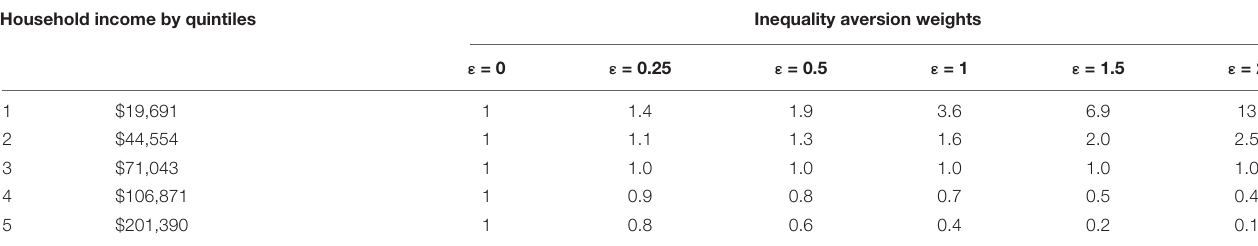
TABLE 3 | Household Income quintiles a (in $ CAD) (2016) (Lapointe, 2019) and Atkinson value estimates for varying inequality aversion weights.